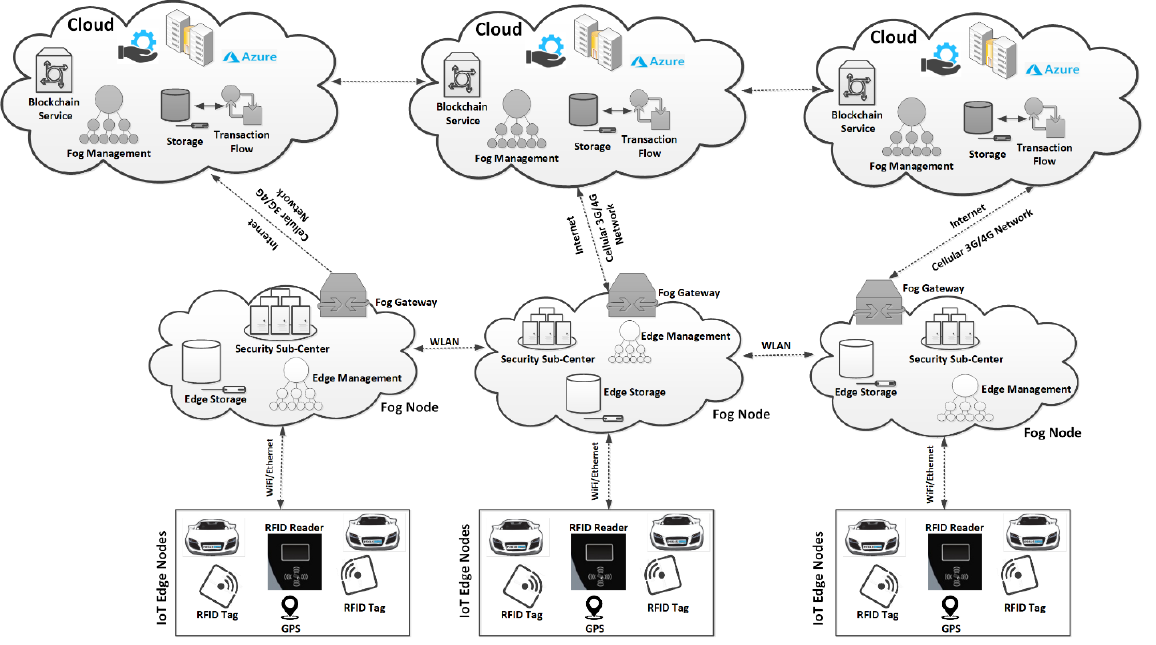
Figure 3. System